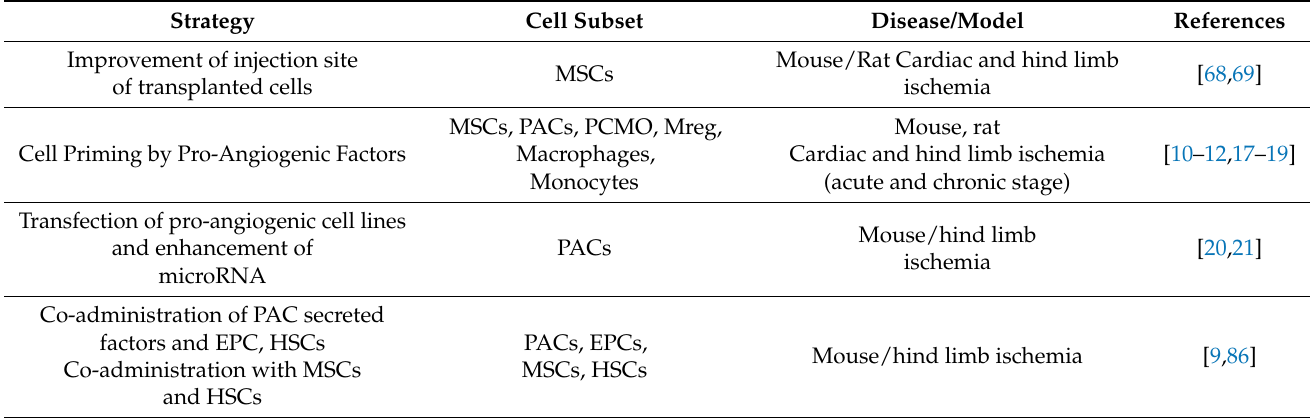
Table 1. Exemplary overview of therapeutic